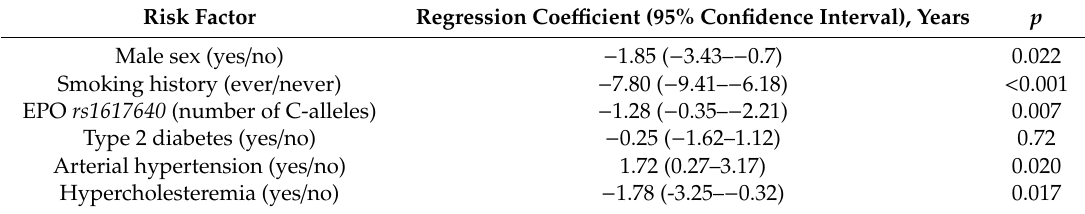
Table 3. Multivariate linear regression analysis of age at onset of peripheral arterial disease (PAD). Risk